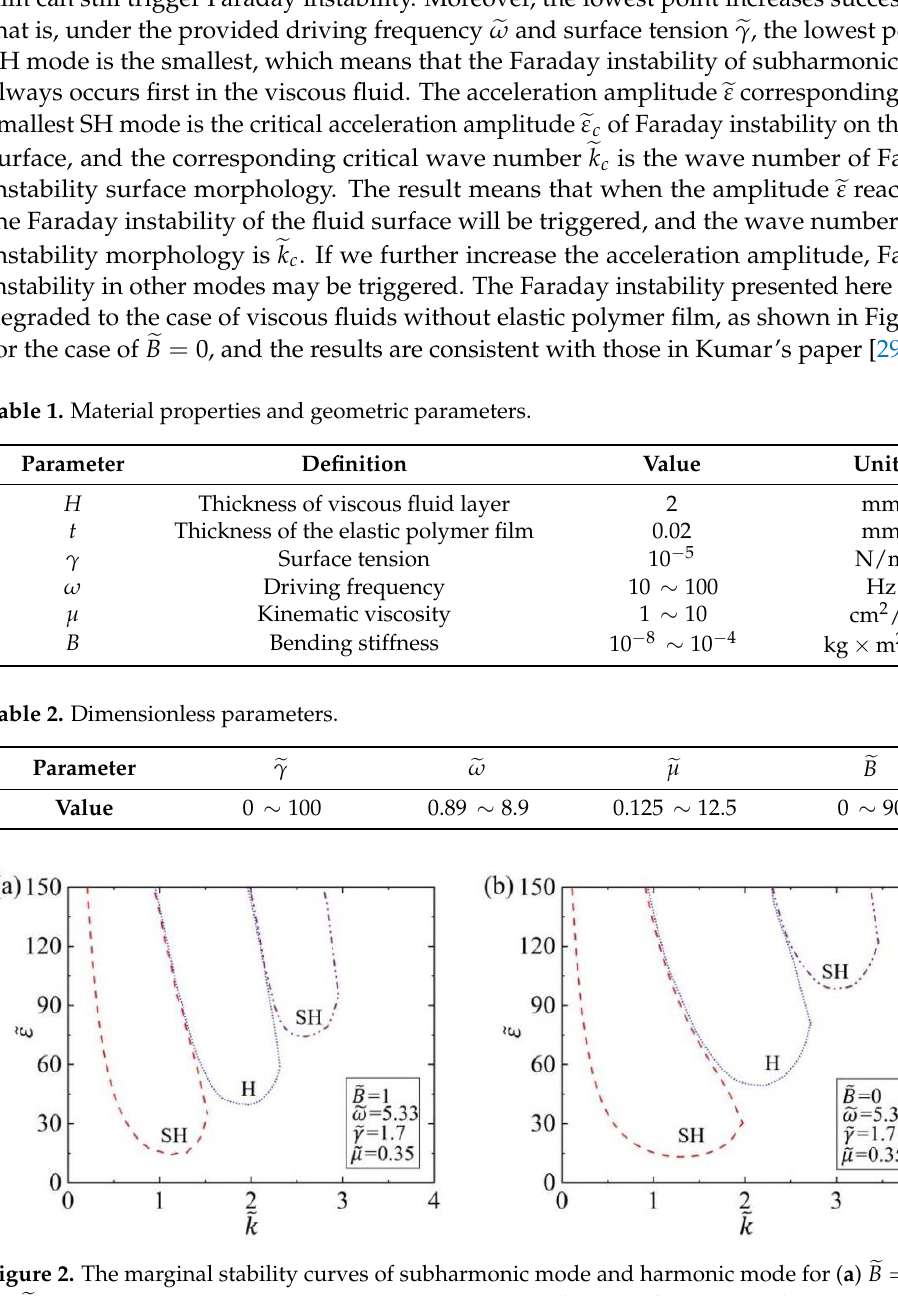
Figure 2. The marginal stability curves of subharmonic mode and harmonic mode for ( a ) ( b ) (cid:101) B = 0, respectively. The dimensionless parameters are (cid:101) ω = 5.33, (cid:101) γ = 1.7, and (cid:101) µ = 0.35. The three tongue-shaped curves all have the lowest point, and Faraday instability in the viscous fluid covered with the elastic polymer film can be triggered when (cid:101) ε is above the lowest